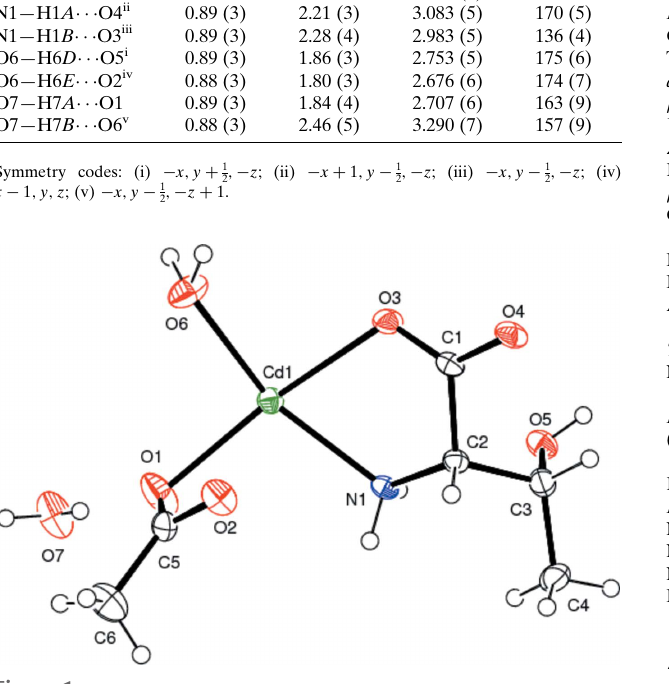
Table 2 Experimental details. Crystal data Chemical